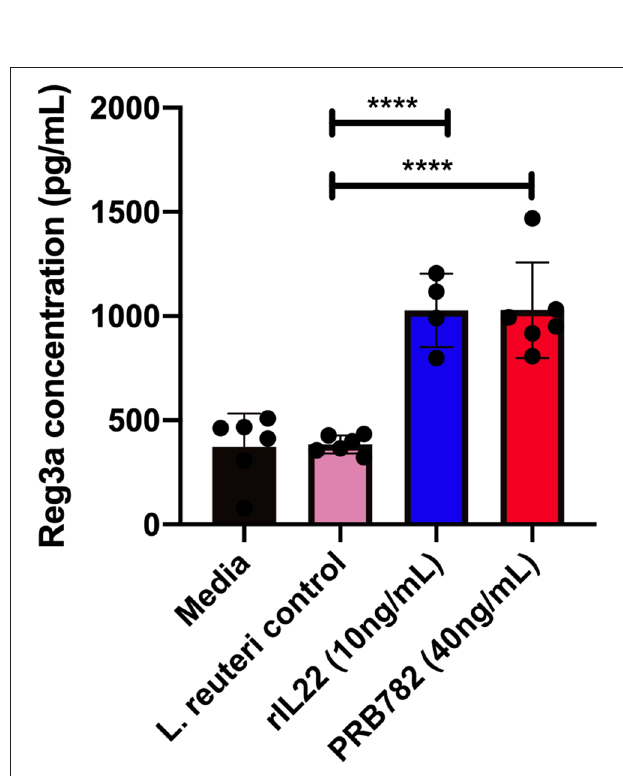
FIGURE 7 | hIL-22 secreted by PRB782 induces production of the antimicrobial peptide Reg3 α in human enteroids. Reg3 α present in enteroids supernatants treated with PRB484, PRB782, and pRB577. Monolayer of enteroids were treated for 16h and detection of Reg3 α was done by ELISA. Data represent the average of six biological replicates. Error bars indicate the standard deviation of the mean. Comparisons performed with analysis of variance (ANOVA) (multiple groups). **** P <